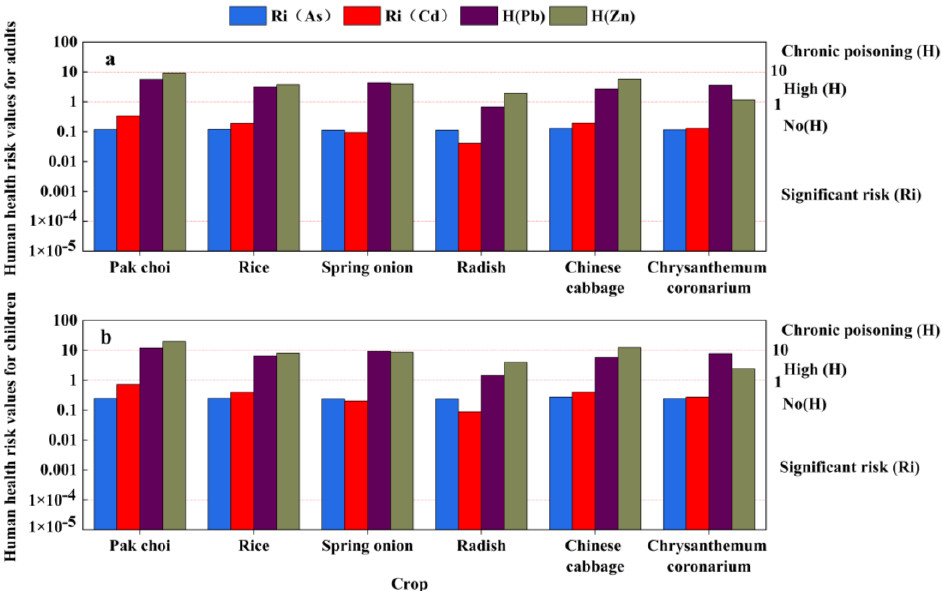
Figure 8. Human health risk values of As, Cd, Pb and Zn in six crops for: ( a ) adults; and ( b ) chil- dren.